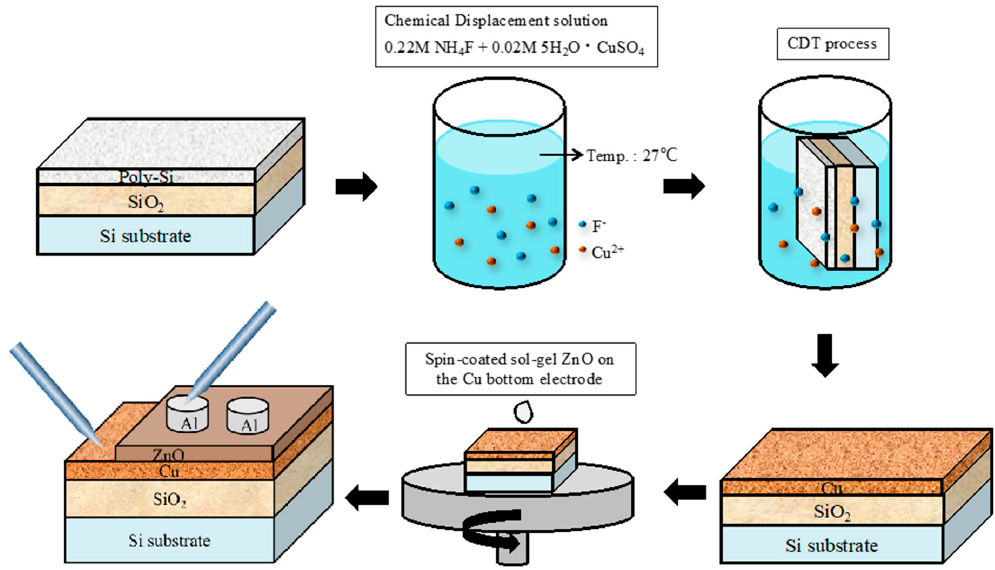
Figure 1. Process flow diagram of fabrication of Cu-CDT ReRAM devices.